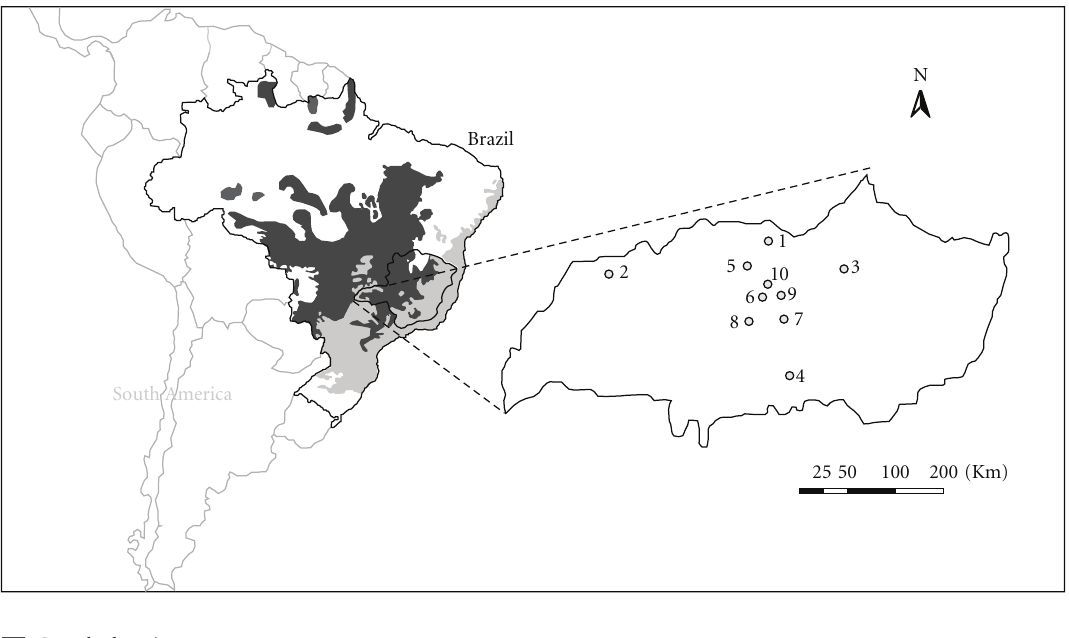
Figure 1: Location of the ten sites of seasonal semideciduous forest studied in the region of Triˆangulo Mineiro, Minas Gerais state, southeastern